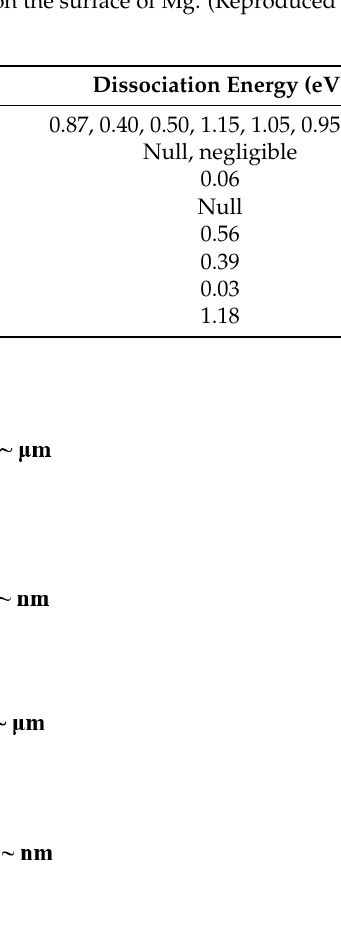
Figure 3. Schematic of the hydrogen absorption/desorption process in the MgH 2 /Mg. (Reproduced with permission from ref. [47]. Copyright 2018 Elsevier.). Table 3. Dissociation energy of hydrogen molecule on the surface of Mg. (Reproduced with permission from ref. [49].